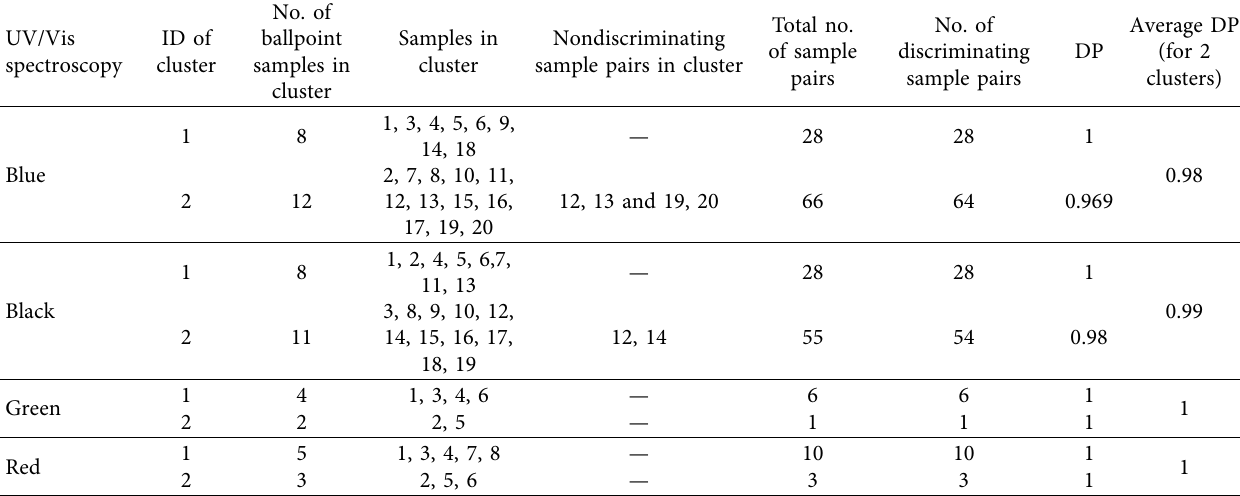
UV/Vis: ultraviolet visible spectroscopy; DP: discriminating power.